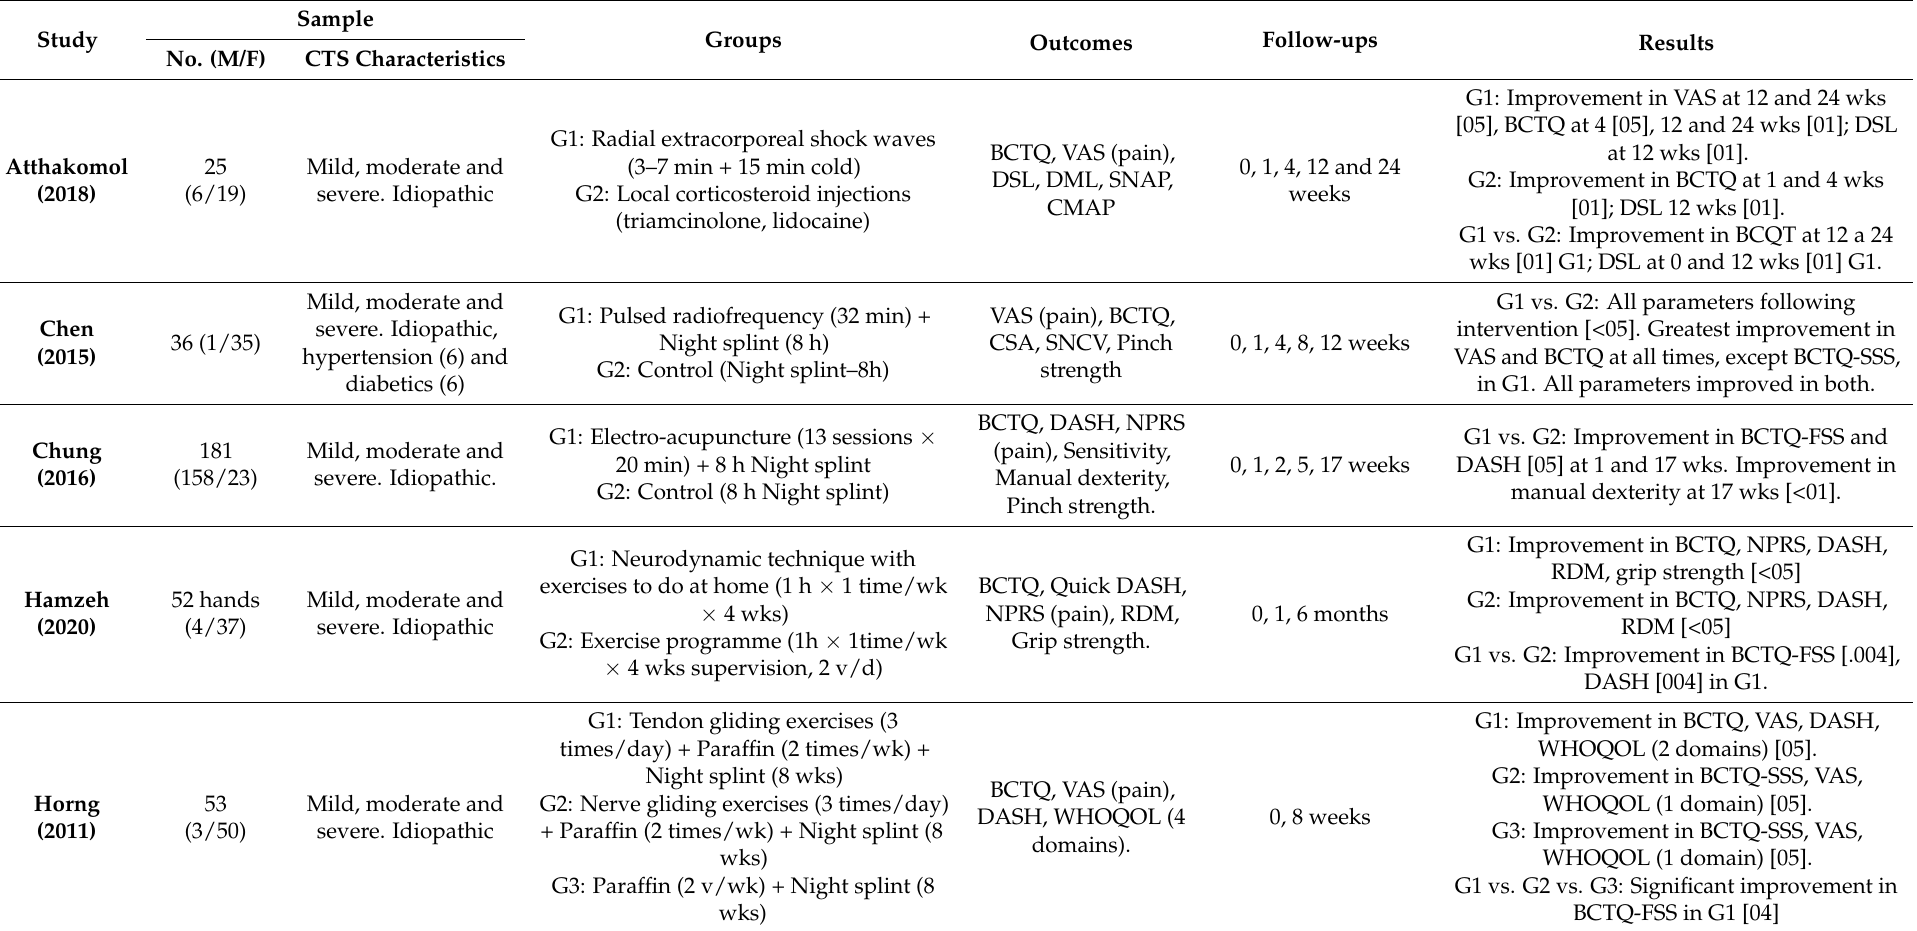
Table 3. Characteristics of Studies: Studies Including Severe and Systemic